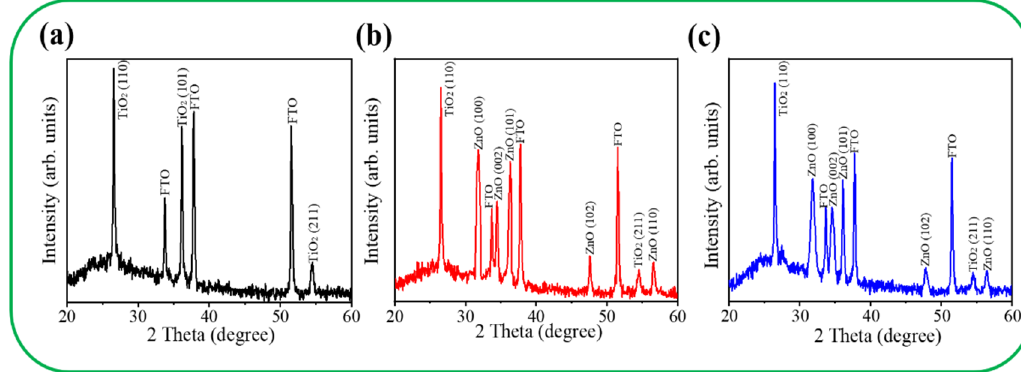
Figure 3. XRD patterns of various samples: ( a ) TiO 2 ; ( b ) TiO 2 − ZnO − C; ( c ) TiO 2 − ZnO − H.